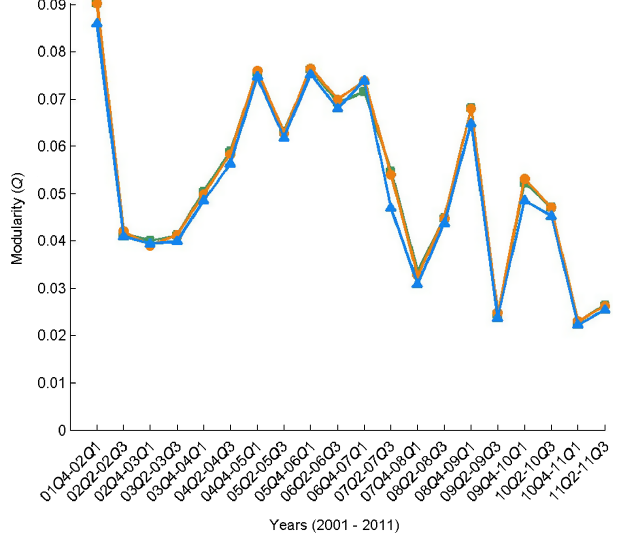
FIG. 18. Temporal trend in the values of Q 3 ð ~ σ (cid:4) Þ for the different algorithms over a six-month sliding window spanning the time frame from October 2001 to October 2011. (The Potts algorithm is shown by green squares, the Louvain algorithm by orange circles, and the spectral algorithm by blue triangles.)